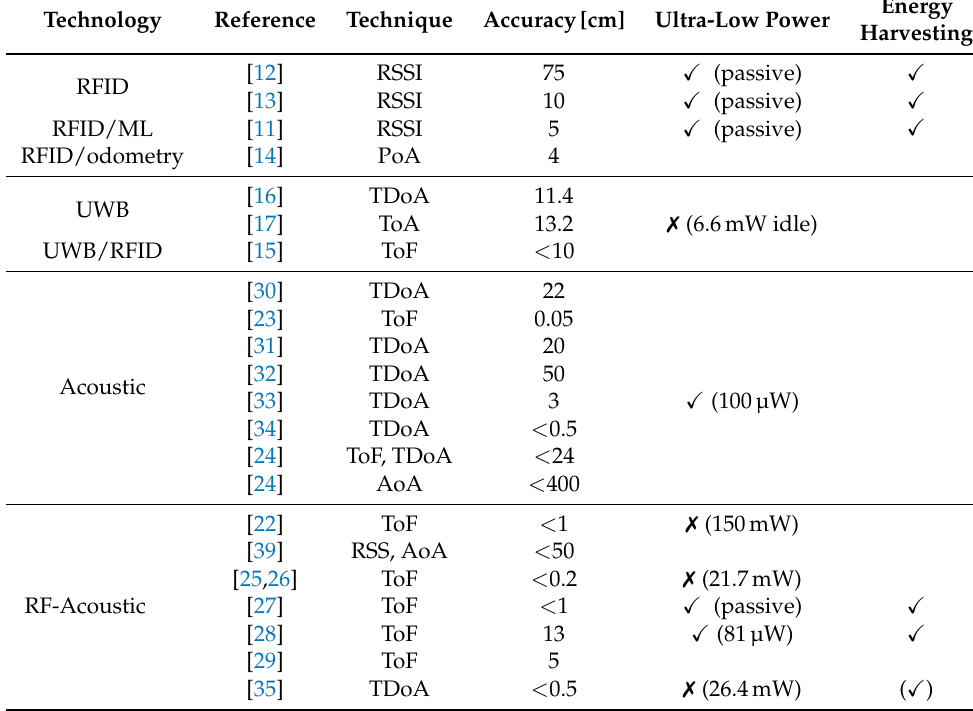
Table 1. Comparative summary of indoor positioning